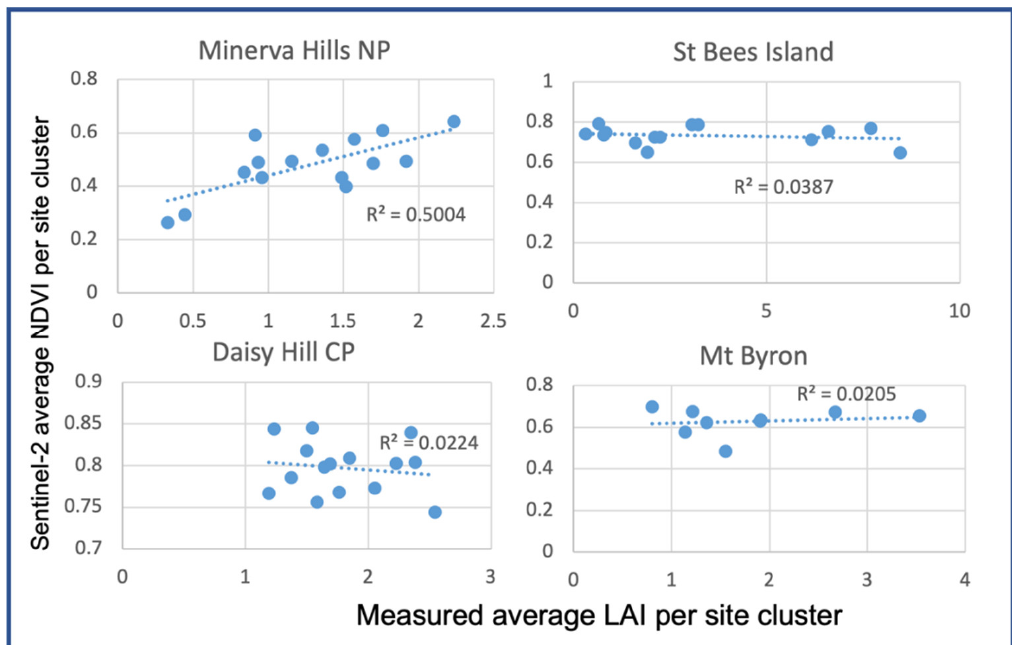
Figure A4. Comparing field measured LAI and Sentinel-2 clusters NDVI.